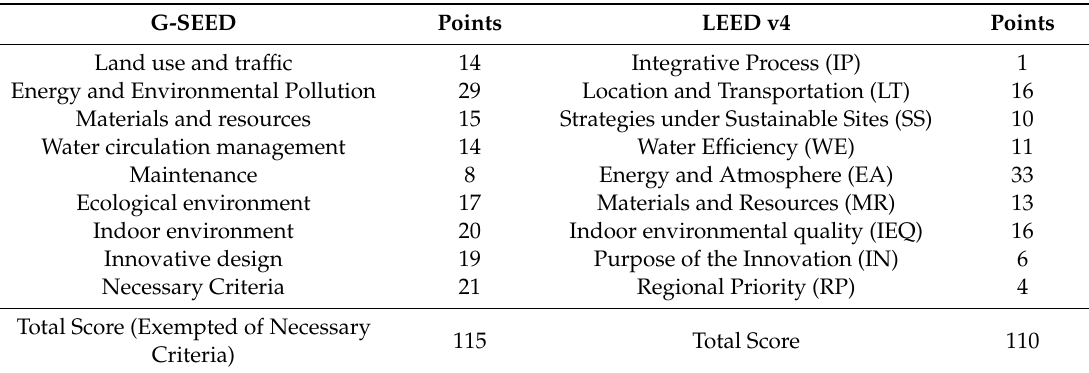
Table 2. G-SEED and LEED Evaluation section scores.